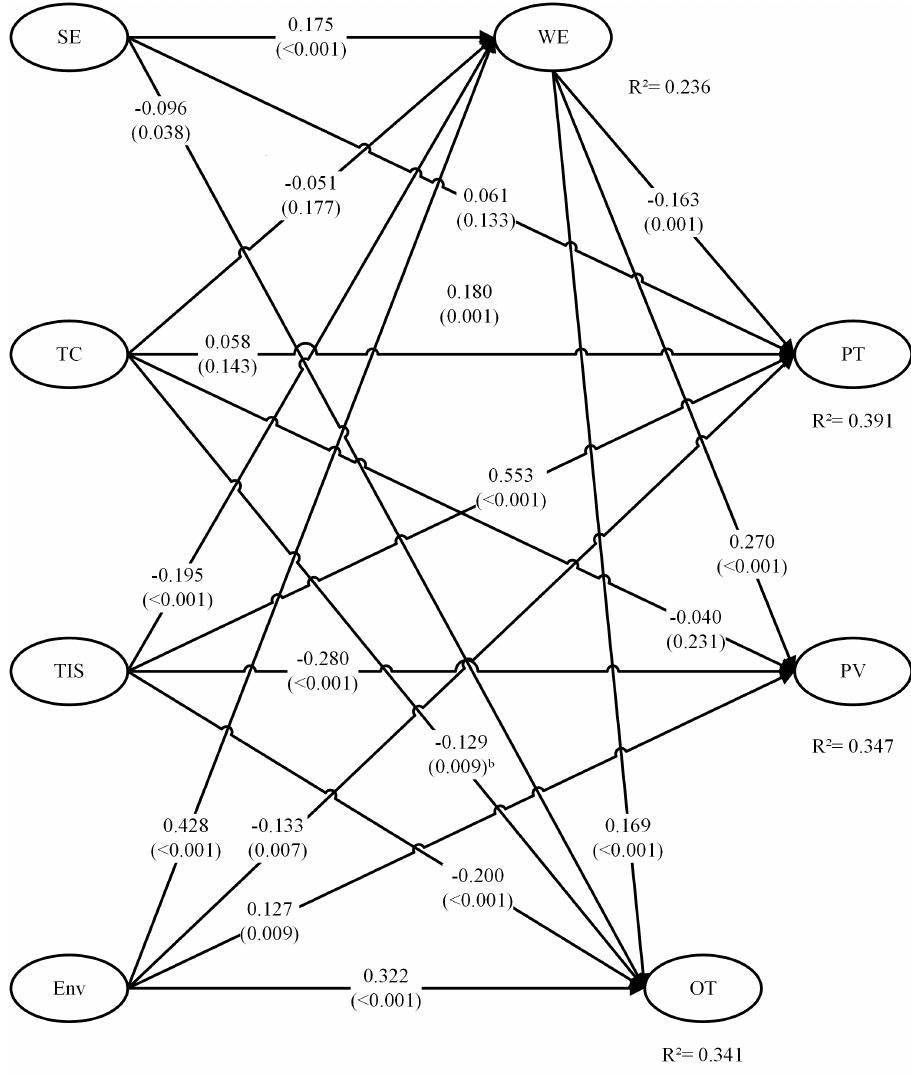
Figure 4: Result of the structural model analysis